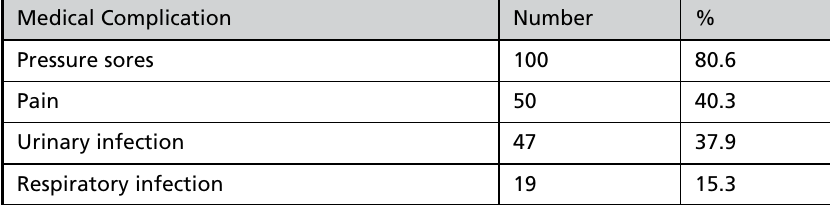
Table 2: Occurrence of secondary medical complications